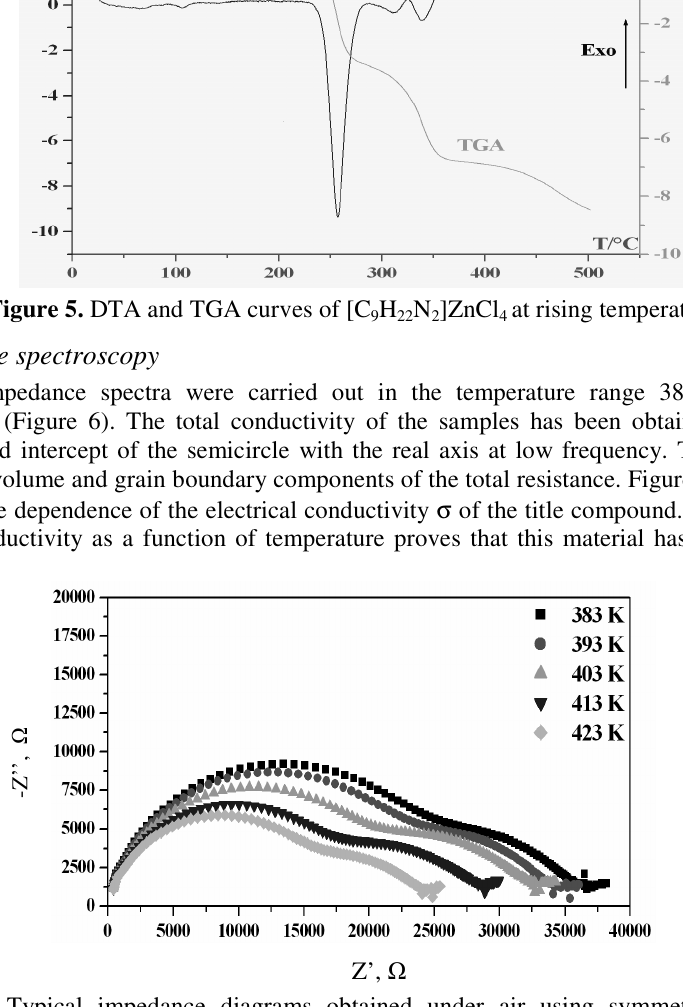
Figure 6. Typical impedance diagrams obtained under air using symmetric cells for [C H N ]ZnCl 9 22 2